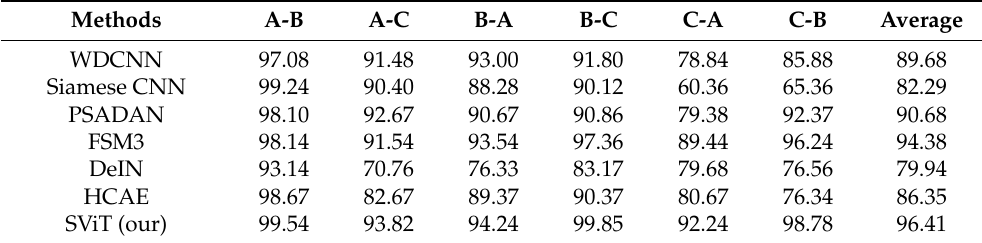
Table 8. Mean classification accuracy (%) with 6000 training samples on CWRU.